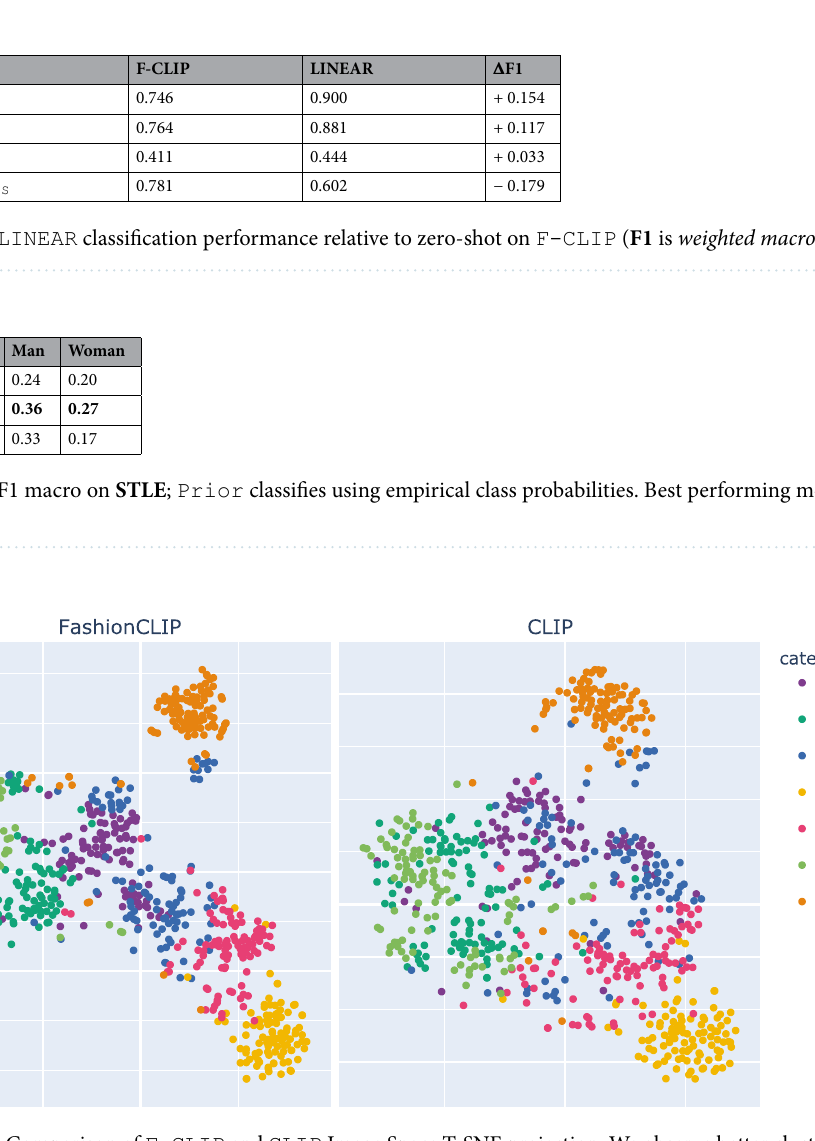
Figure 5. Comparison of F-CLIP and CLIP Image Space T-SNE projection. We observe better clustering (0.115 vs 0.0745 silhouette score 58 ) in F-CLIP for categories such as Shirts, Skirts and Dresses, where the products form a denser cluster with less overlap between categories, suggesting that the F-CLIP latent space is better tuned for fashion